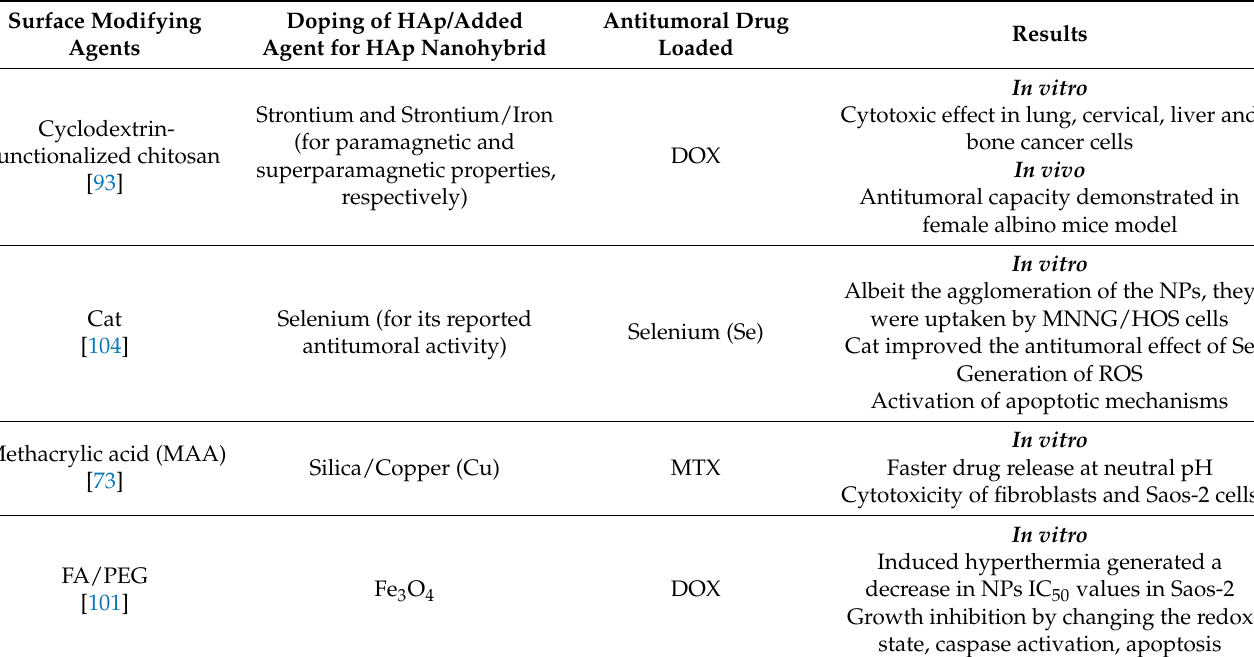
Table 2. Functionalization of doped HAp or HAp nanohybrids for cancer